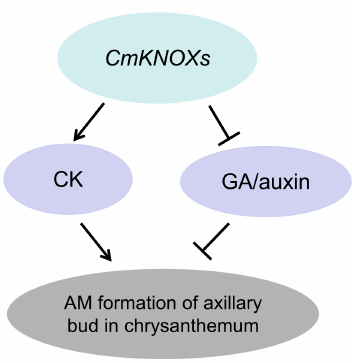
Figure 12. KNOX genes regulate axillary bud formation of chrysanthemums by affecting hormone pathways ( CmKNOXs represent CmKNAT1 , CmKNAT6 , and CmSTM , CK represents cytokinin, GA represents gibberellin, and AM represents axillary